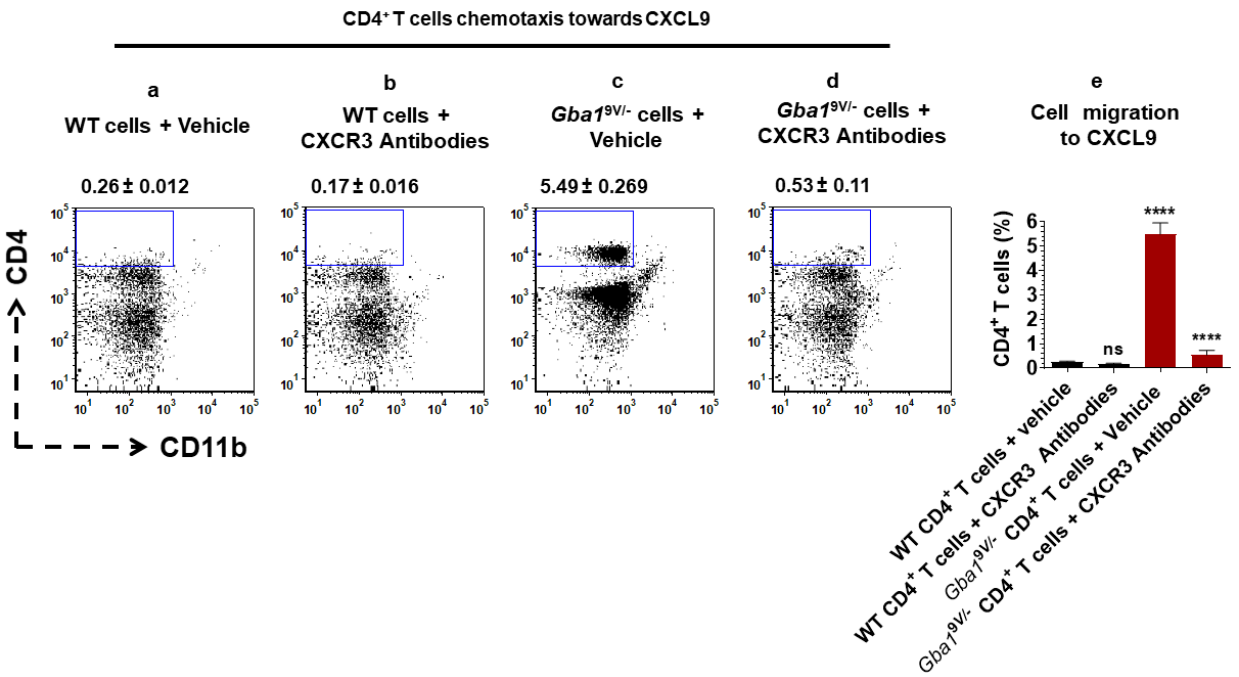
Figure 4. CXCR3 targeting alters CXCL9-mediated CD4 + T cells chemotaxis in Gba1 9V/- mice. CD4 + T cells purified from spleen of WT and Gba1 9V/- mice ( n = 5/group) were allowed to migrate towards CXCL9 (16 nM) in the presence and absence of mouse anti-CXCR3 antibodies (10 µg/mL) at 37 °C and 5% CO 2 for 45 min. Cells that had migrated through the filter and had attached to the lower side of the filter were collected and analyzed by FACS. Percentage of CD4 + CD11b − T cells are shown from the ( a ) vehicle (PBS) treated WT cells and their migration to CXCL9, ( b ) mouse anti-CXCR3 antibodies treated WT cells and their migration to CXCL9, ( c ) PBS treated Gba1 9V/- cells and their migration to CXCL9, and ( d ) mouse anti-CXCR3 antibodies treated Gba1 9V/- cells and their migration to CXCL9. ( e ) WT (black columns), Gba1 9V/- (maroon columns) and the values shown in the bar diagram are the mean ± SD. and group comparison were performed with ANOVA. Three independent experiments were conducted (**** p < 0.0001).